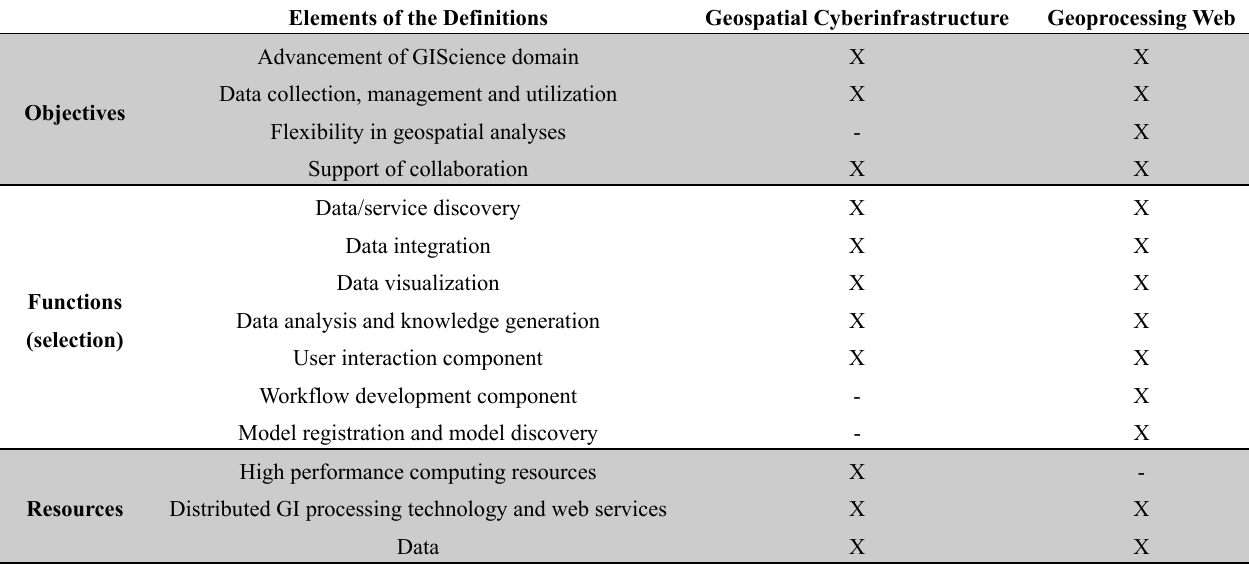
Table 1. A comparison of the definitions of geospatial cyberinfrastructure (GCI) and the geoprocessing